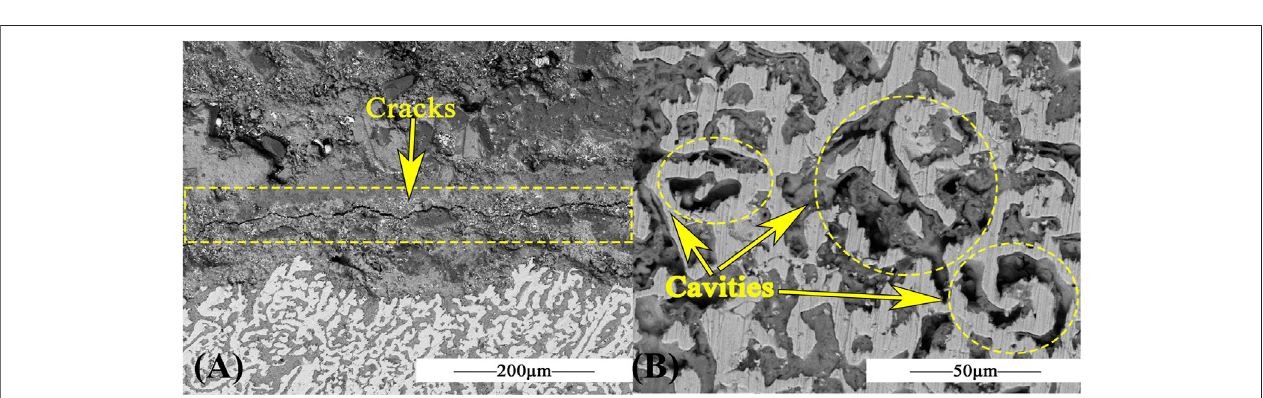
FIGURE 8 | SEM of AFA 310S for 360h at 800 ° C in chloride salt: (A) SEM image for cross section, (B) SEM image for matrix.